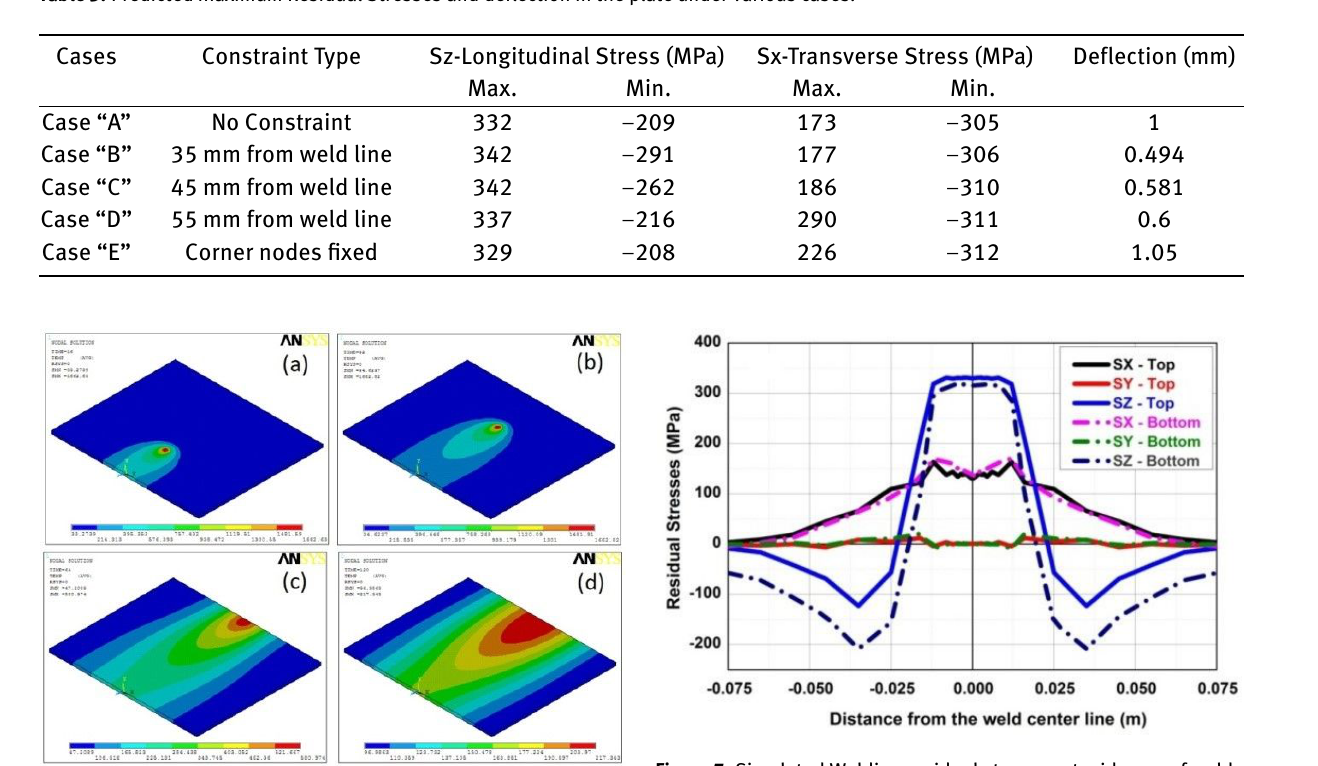
Table 3: Predicted Maximum Residual Stresses and deflection in the plate under various cases.